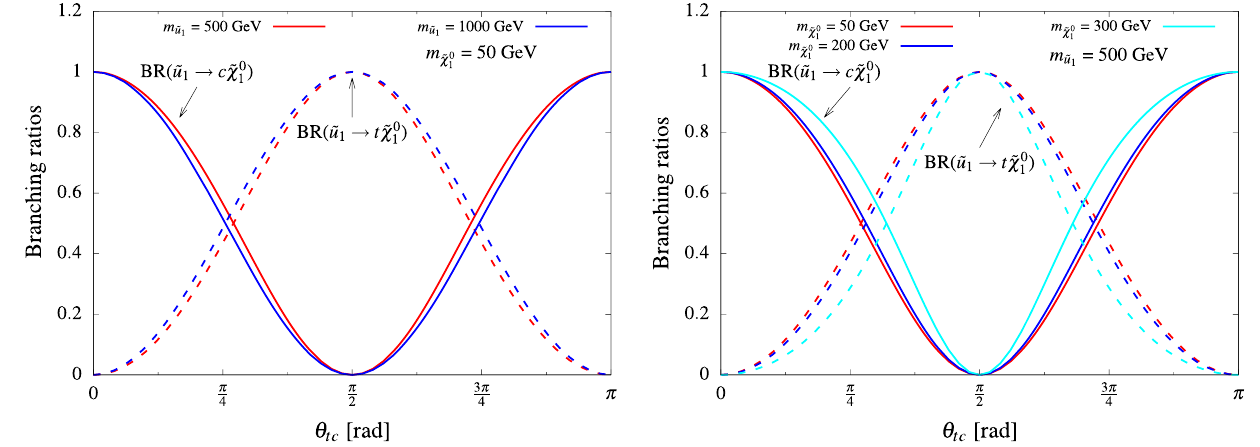
= 50 GeV. In the right panel, the neutralino mass varies and to m ˜ χ 0 ) (dashed) 1 1 is fixed to 50 GeV (red), 200 GeV (blue) and 300 GeV (cyan), for a = 500 squark mass of m ˜ u 1